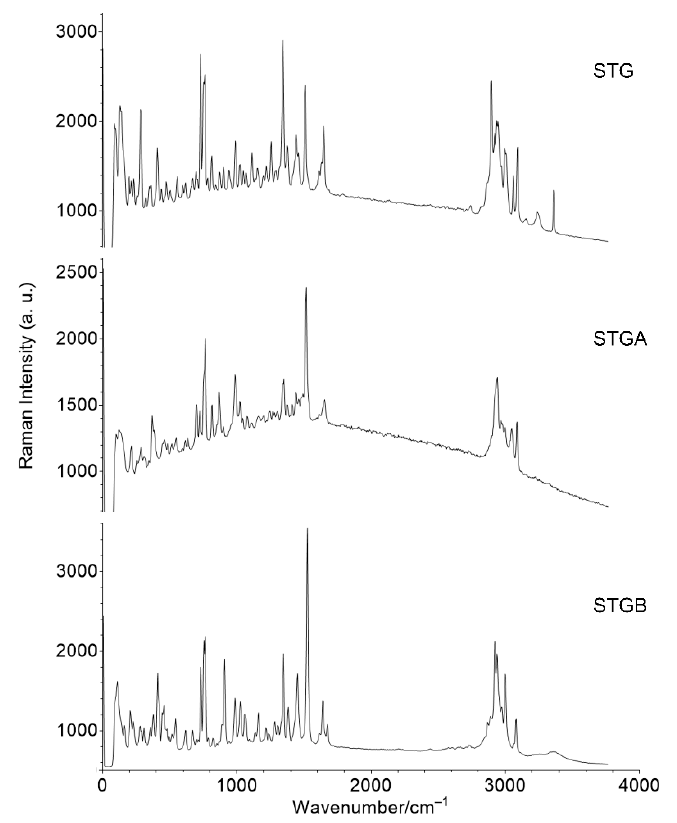
Figure 12. Raman spectra for sitagliptin phosphate monohydrate (STG), sitagliptin phosphate anhydrous (STGA) and sitagliptin base form (STGB).